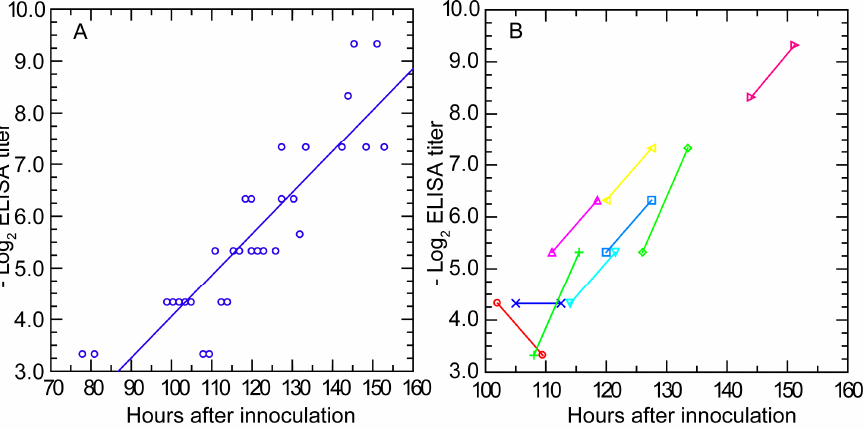
Figure 7. Serum antibody to whole cells of B. hermsii by enzyme-linked immunosorbent assay (ELISA) over time in infected mice. The experiment and blood collection protocol are the same as described for Figure 3. Panel ( A ) is a scatter plot of log-transformed reciprocal titer values for individual mice against time in hours after inoculation; Panel ( B ) shows pairs of values for nine individual mice obtained 7.5 h apart and denoted by different colors and symbols as given in the figure.